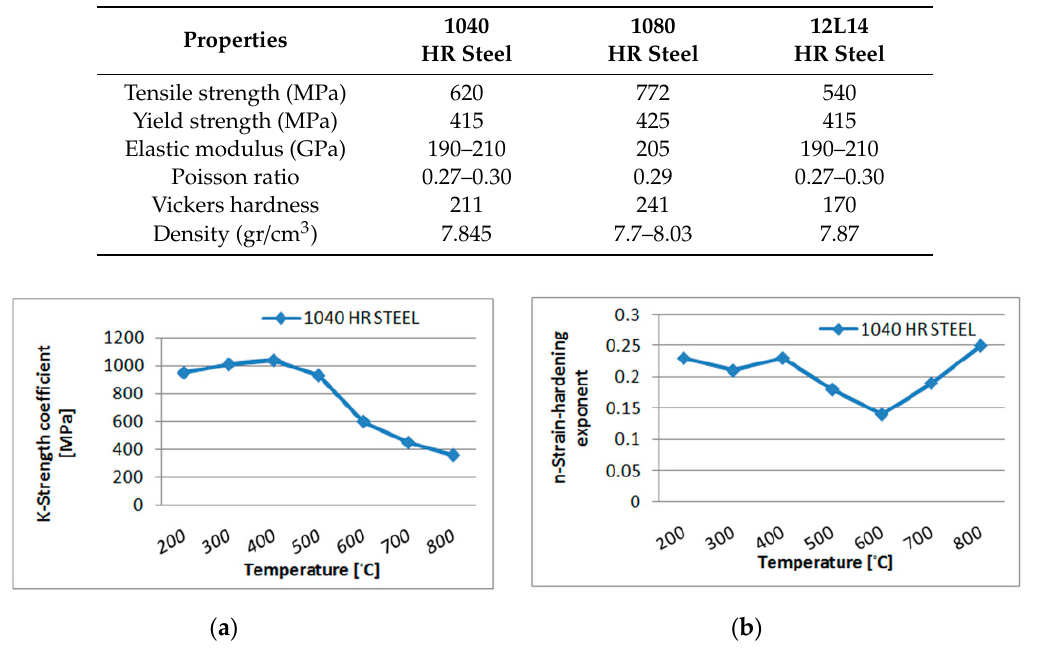
Table 1. Properties of three di ff erent hot-rolled (HR) steel materials.